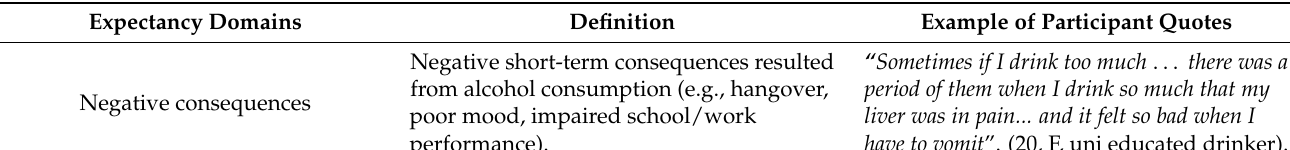
Table 2. Drinking expectancy domains, definitions, and sample quotes from the Hong Kong young adult focus group participants aged 18–34 ( n =